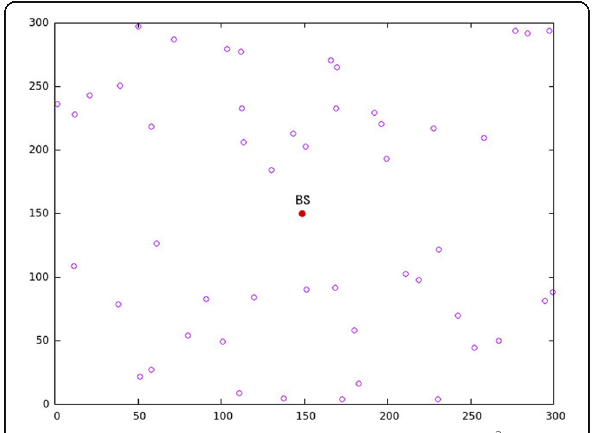
Fig. 9 The comparison of energy usage for LEACH, LEACH-C, EE- LEACH, and LEACH-M in 300 × 300m 2